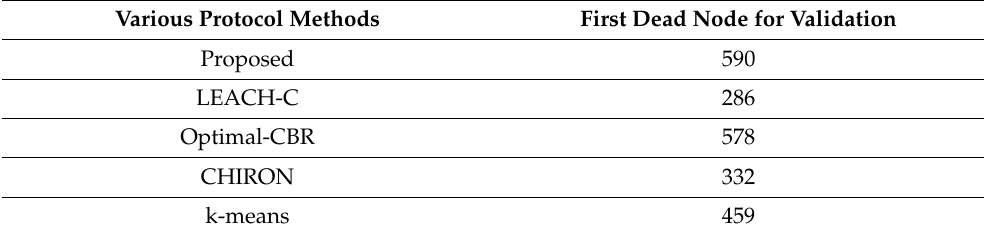
Table 3. Differentiation of first dead node for validation in several methods.